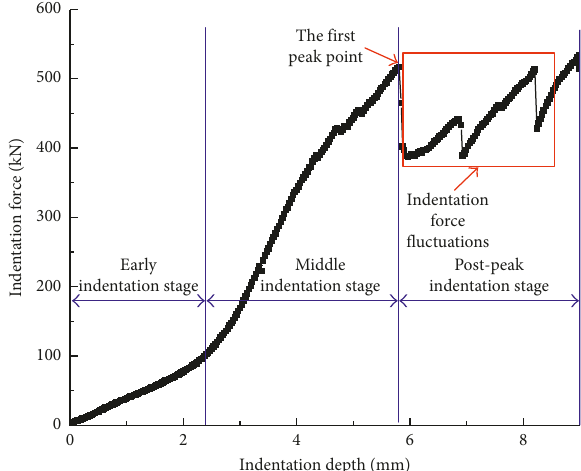
Figure 5: The typical indentation force-depth